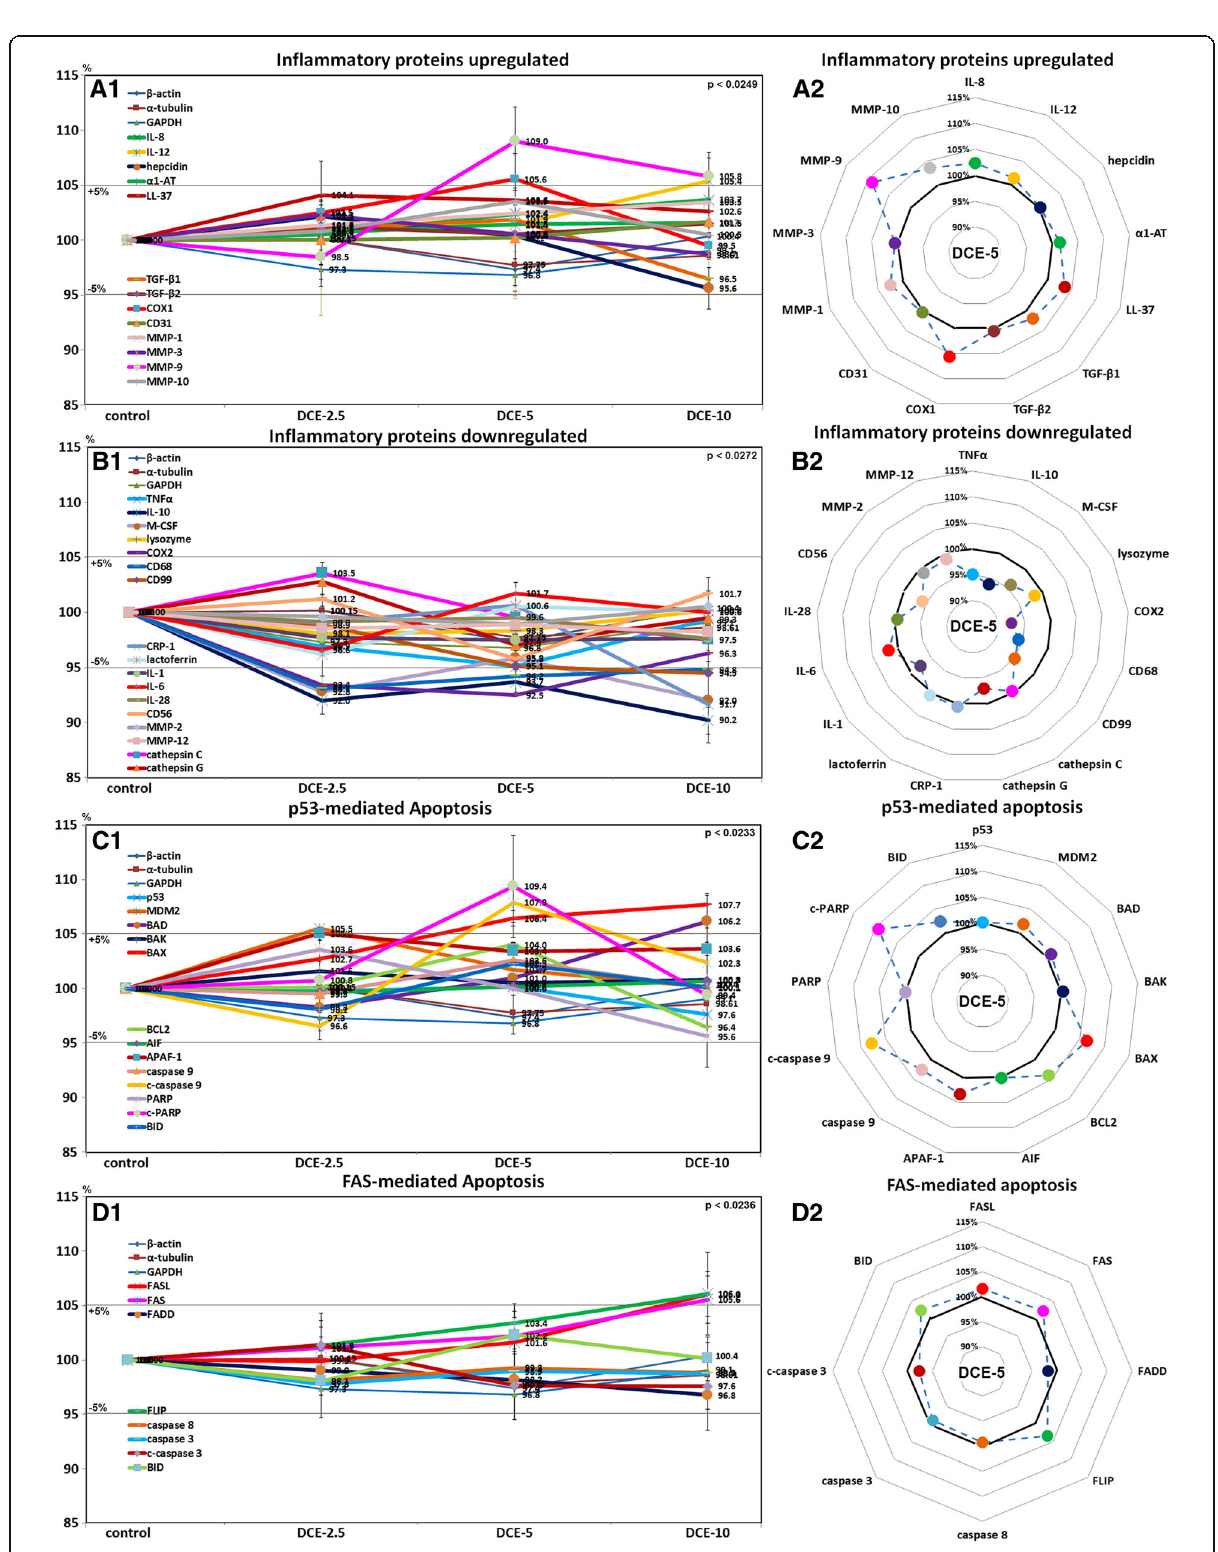
Fig. 6 Expressions of inflammatory proteins upregulated ( a ), inflammatory proteins downregulated ( b ), p53-mediated apoptosis proteins ( c ), and FAS-mediated apoptosis proteins ( d ) after DCE treatment in mouse livers as determined by IP-HPLC. Major protein expression pattern induced by DCE-5 was found in the radial graphs of A2, B2, C2, and